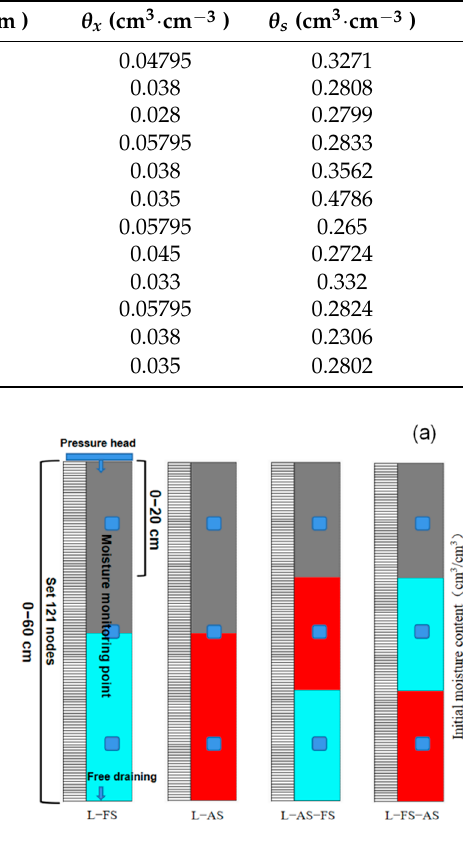
Figure 5. Model discrete schematic diagram and monitoring point setting basis. ( a ) is the schematic of profile simulation and boundary settings. ( b ) is the initial moisture content of the loess and sandstone samples at the depths of 0–60 cm determined by analyzing ANOVA results.